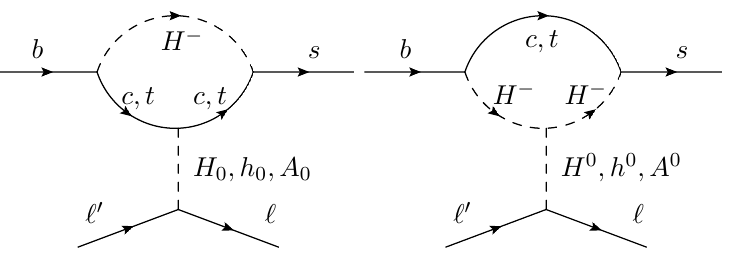
in eqs. (3.34). S ( P )( HH )